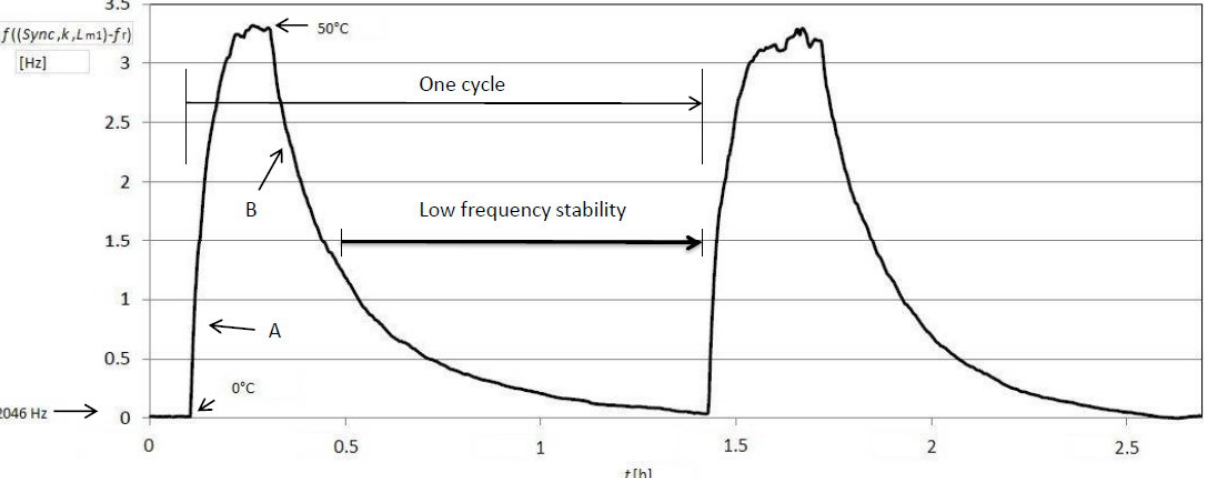
(cid:4667) (cid:3398) (cid:1858) (cid:4667) occurring when changing the (cid:3040)(cid:2869) (cid:3045)